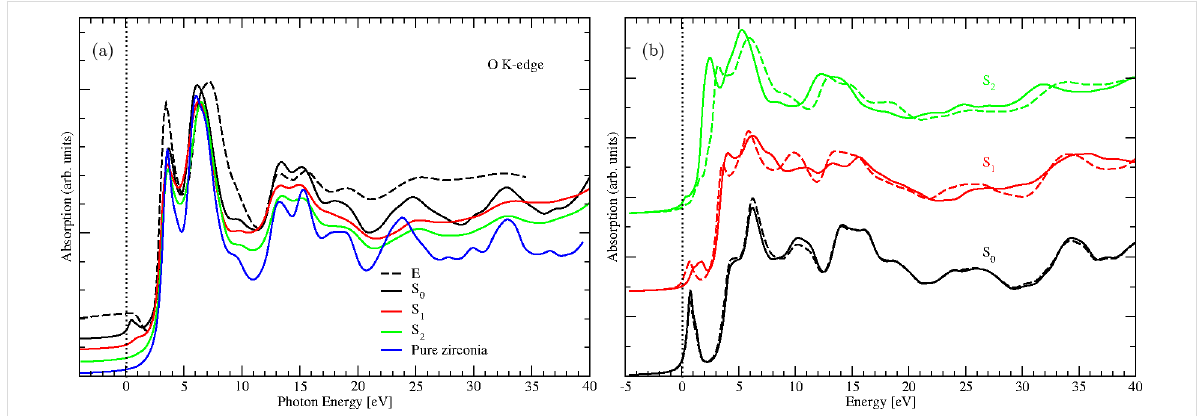
Figure 3: (a) O K-edge spectra of pure zirconia (blue curve) and of nickel-doped zirconia (ZrO 2 :Ni) at x = 6.25 atom % Ni concentration and varying number of vacancies. The notations S 0 , S 1 , and S 2 correspond to the doped structures containing zero, one, and two oxygen vacancies, respectively. Note the presence of the pre-edge peak, which decreases when the number of oxygen vacancies increases. Also, the black, red, and green curves are the XANES spectra obtained from the averages of 64, 63, and 62 individual O K-edge spectra in the zirconia supercell, while the spectrum E (black dashed line) corresponds to the experimental O K-edge spectrum in iron-doped zirconia (ZrO 2 :Fe) at x = 6 atom % Fe concentration from [27]. (b) The mean contributions of the first oxygen shells around the nickel atoms Ni1 (solid lines) and Ni2 (dashed lines) to the O K-edge spectra of the structures S 0 , S 1 , and S 2